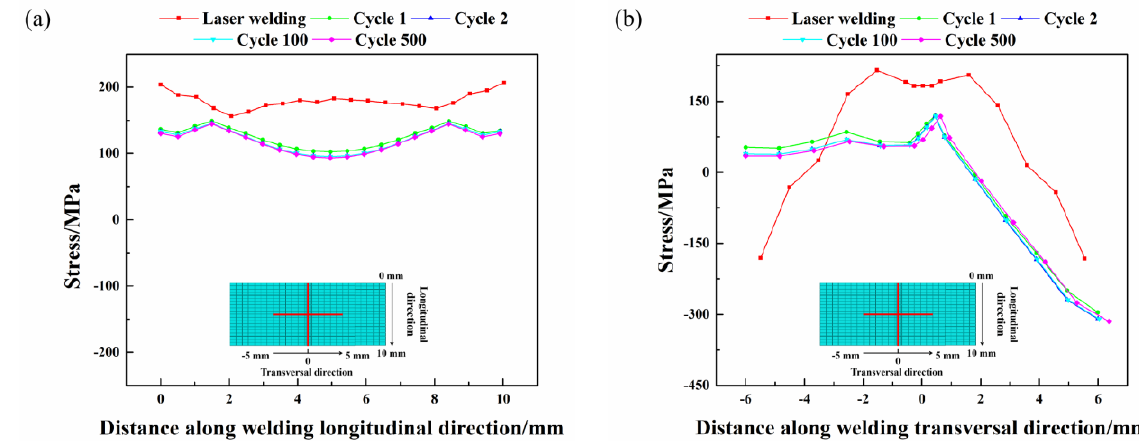
Figure 16. Evolution of residual stress for ( a ) longitudinal, ( b ) transversal.